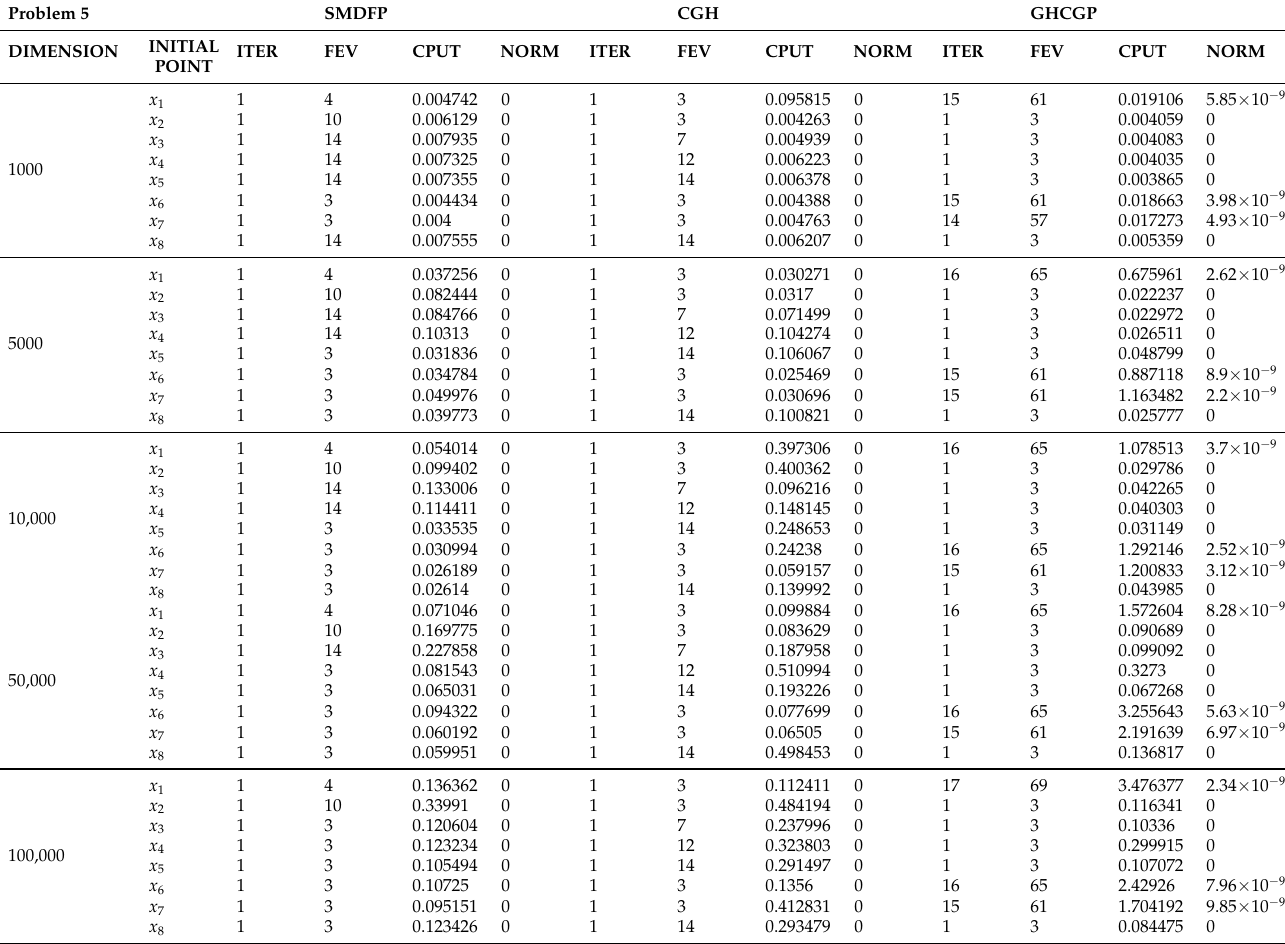
Table 5. Numerical comparison of the SMDFP, CGH [61], and GHCGP [62] methods.